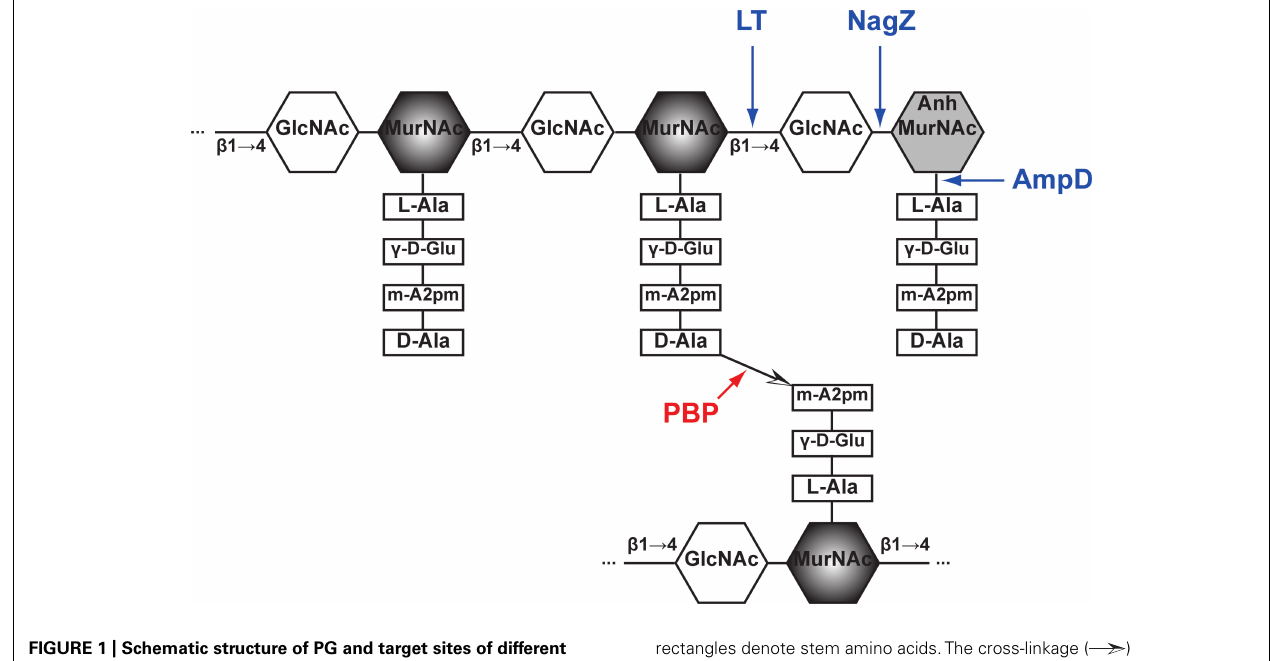
FIGURE 1 | Schematic structure of PG and target sites of different enzymes (pointed by color arrows). The synthetic enzyme (PBP) is highlighted in red while the lytic enzymes (NagZ, AmpD, and LT) are highlighted in blue. Notably, NagZ and AmpD catalyze the liberated muropeptides instead of intact PG. Hexagons denote sugars while